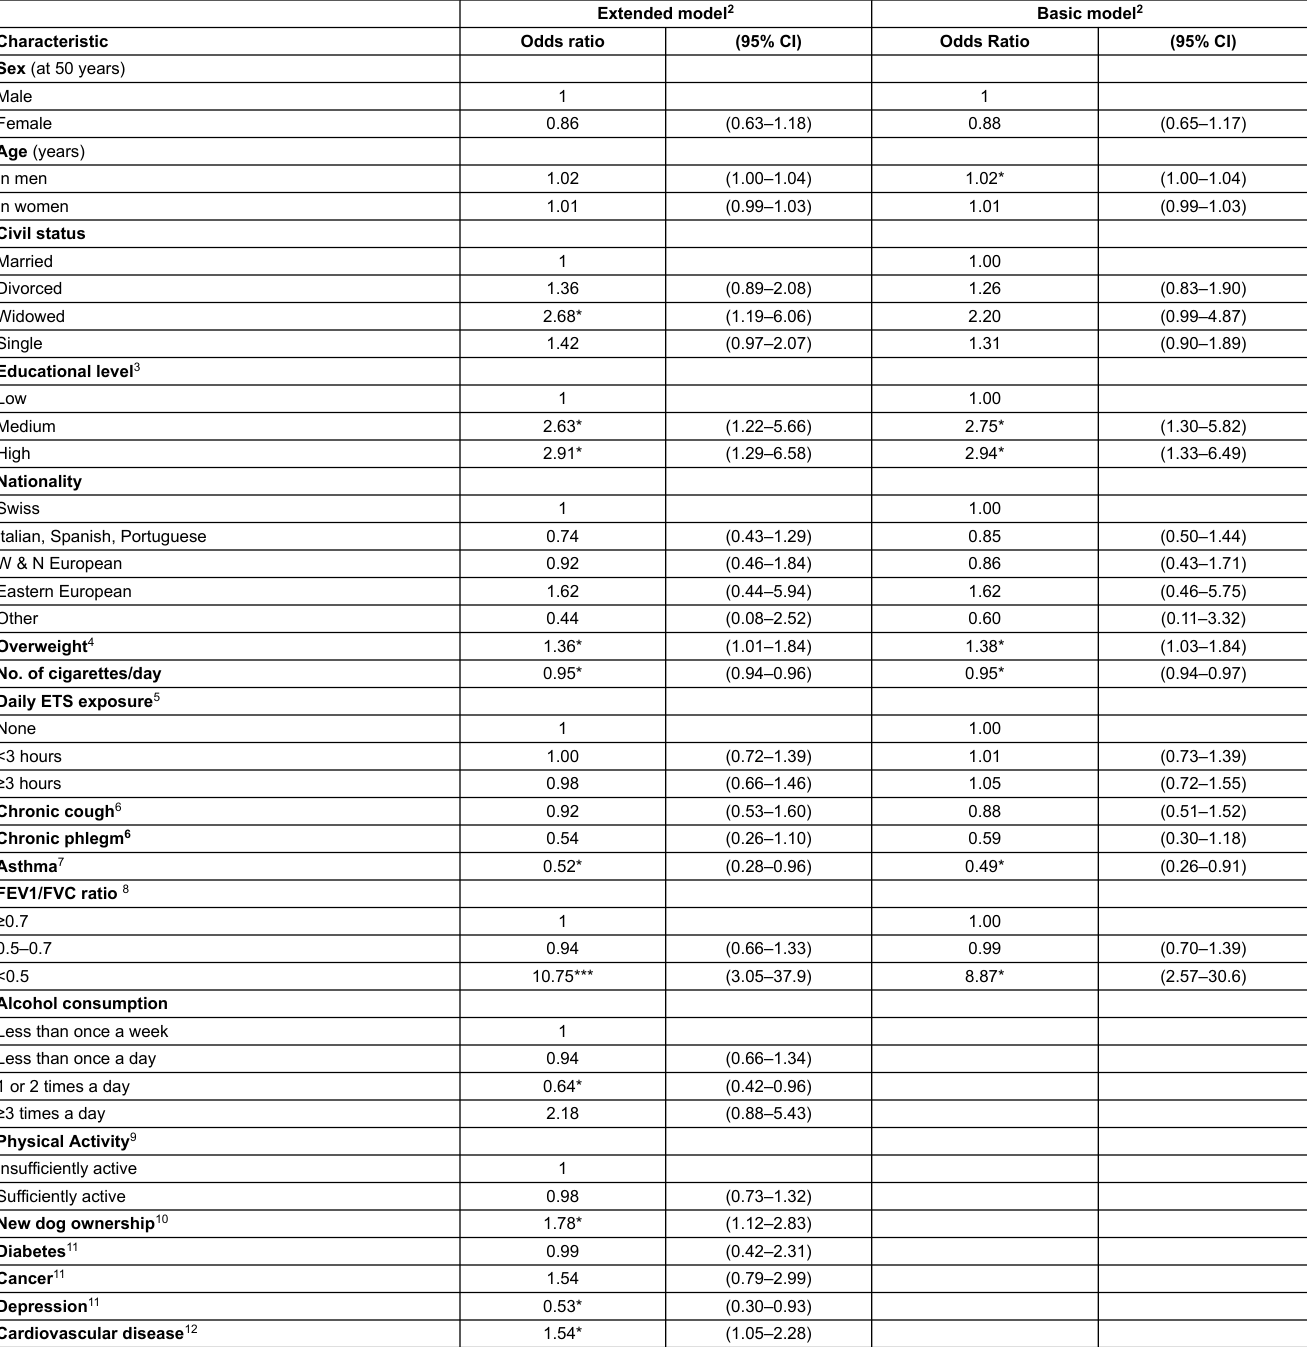
Table S2: Estimated independent associations of smoking cessation between SAPALDIA2 (2002) and SAPALDIA3 (2010/11) with different personal characteristics assessed at SAPALDIA2 1 , comparison of basic and extended